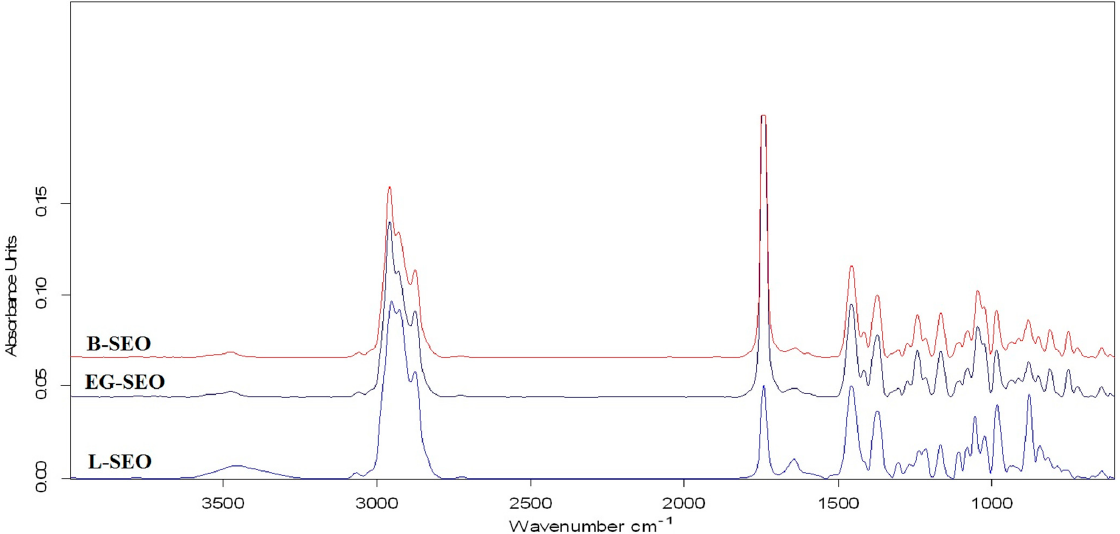
Figure 2. The ATR-FTIR spectra of the Salvia officinalis L. essential oil samples. Table 2. The ATR-FTIR absorption band for SEO samples and vibrational assignments.